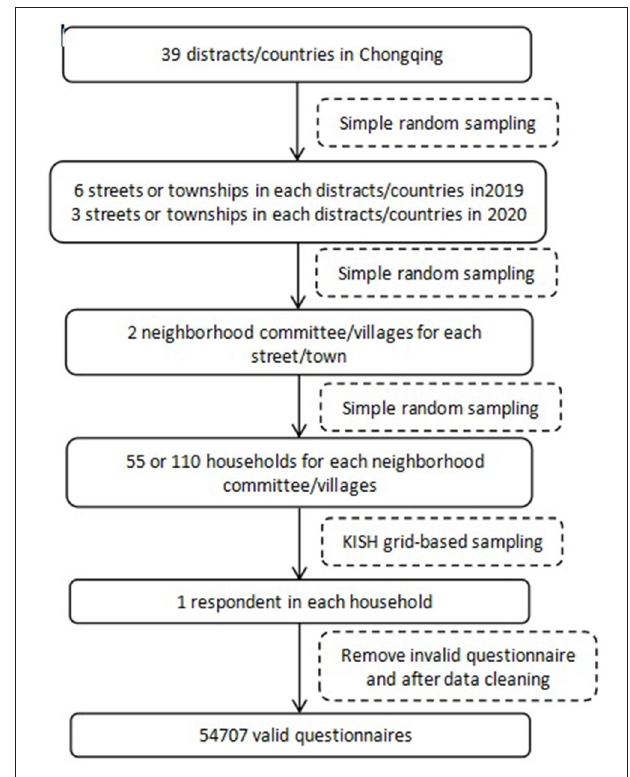
FIGURE 1 | Implementation steps of